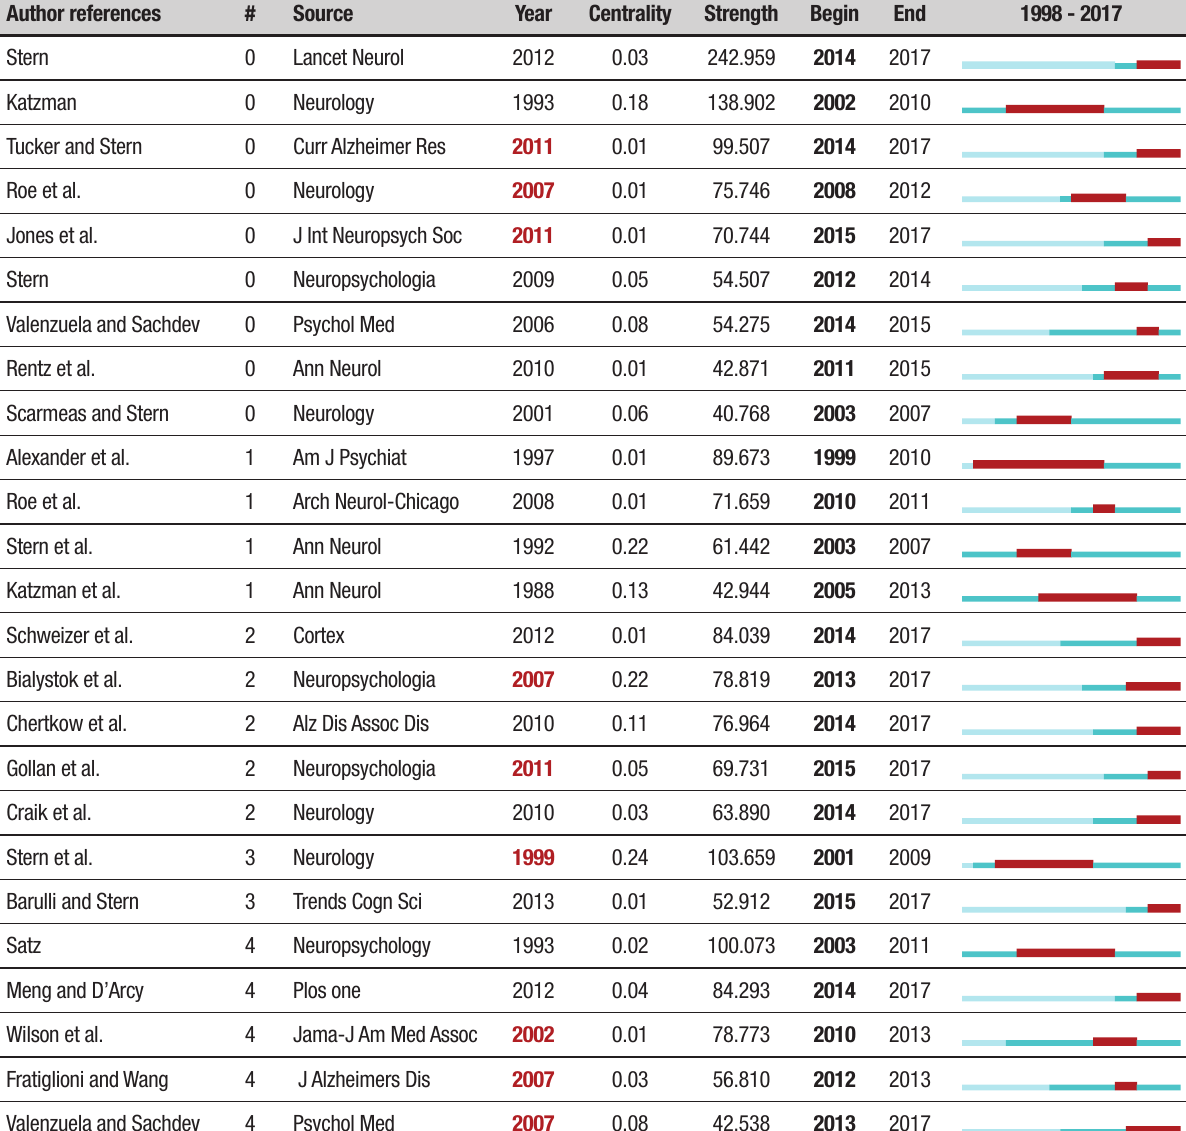
Table 3. Structurally and temporally significant